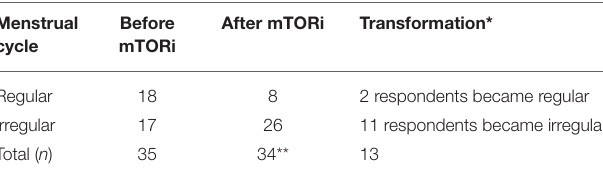
TABLE 4 | Comparison between regular and irregular cycles before and after mTORi